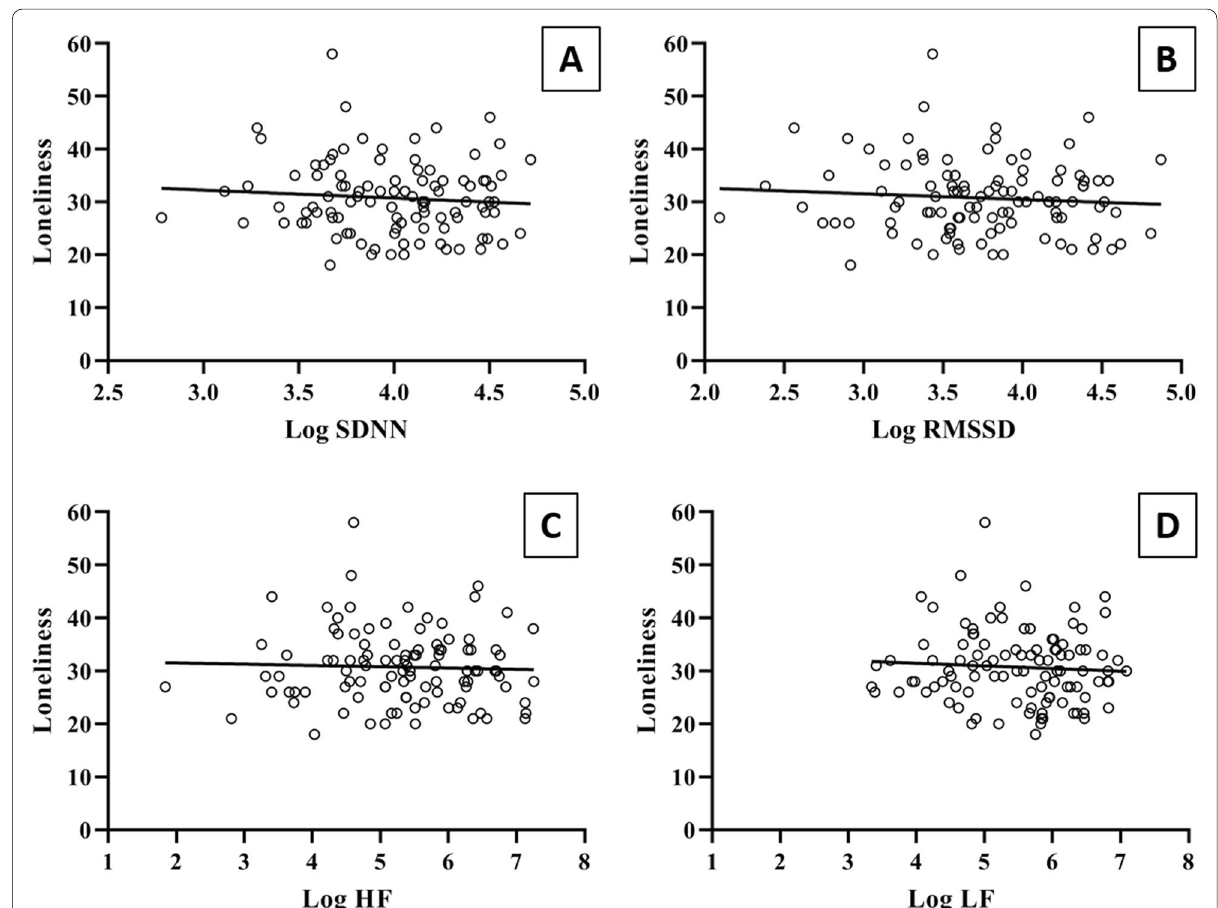
Fig. 2 Graphic representation of regression analyses of loneliness and heart rate variability variables. A Regression analyses predicting loneliness as a function of SDNN ( Β 0.12, p 0.57). B Regression analyses predicting loneliness as a function of RMSSD ( Β =− = analyses predicting loneliness as a function of log HF ( Β 0.05, p 0.82). D Regression analyses predicting loneliness as a function of log LF ( Β =− = 0.10, p =